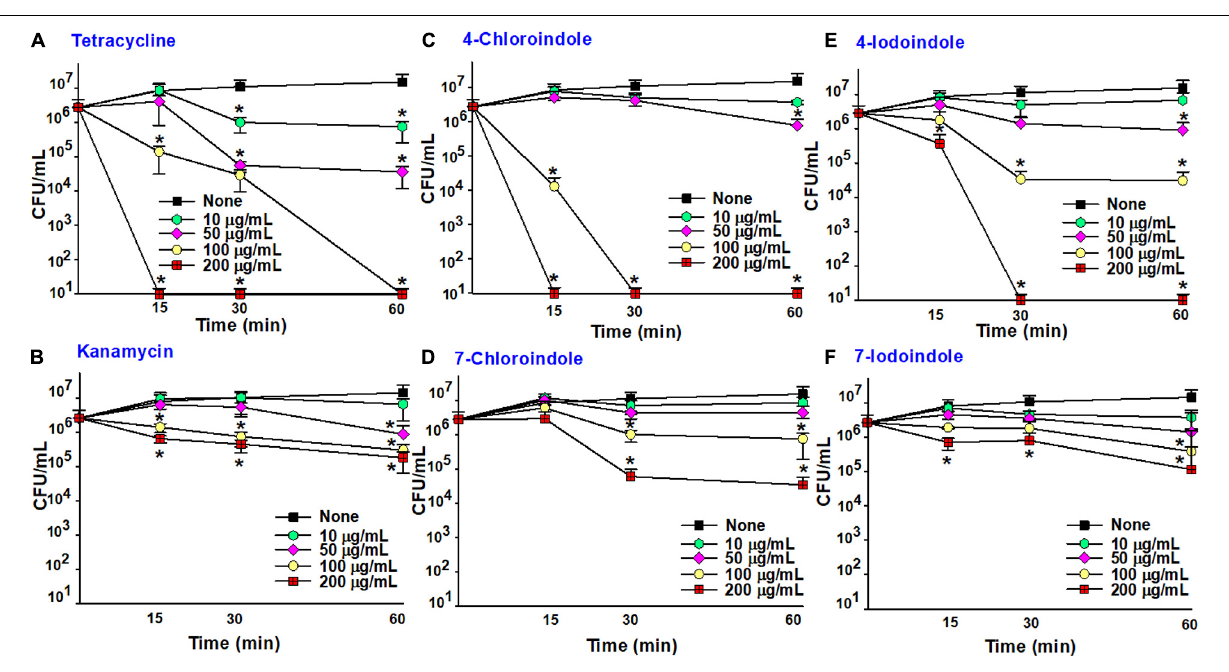
Hydrogen donor, R; aromatic rings (DRR)